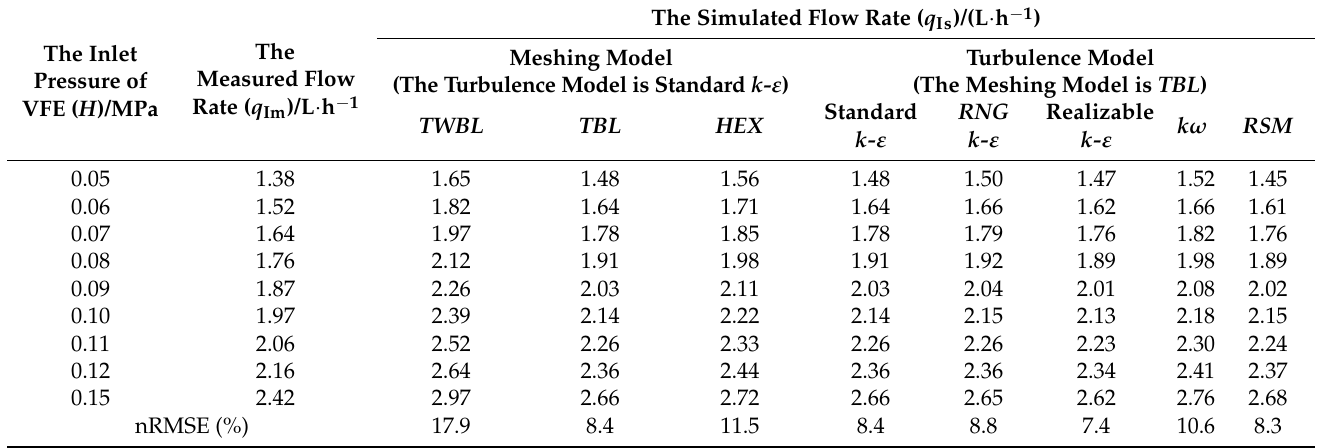
Table 2. Comparison between measured and simulated flow rates of the VFE in working stage